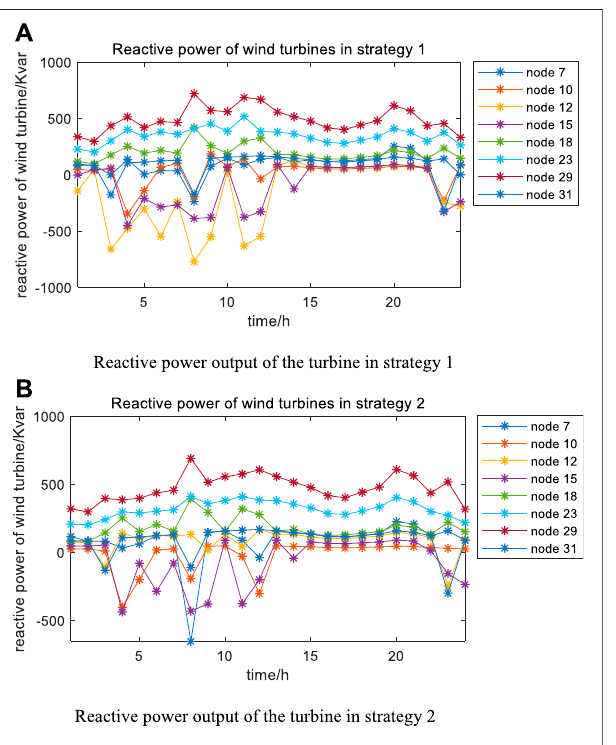
FIGURE 7 | Reactive power outputs of the wind turbines in strategy 1 and strategy 2. (A) Reactive power output of the turbines in strategy 1. (B) Reactive power output of the turbines in strategy 2.